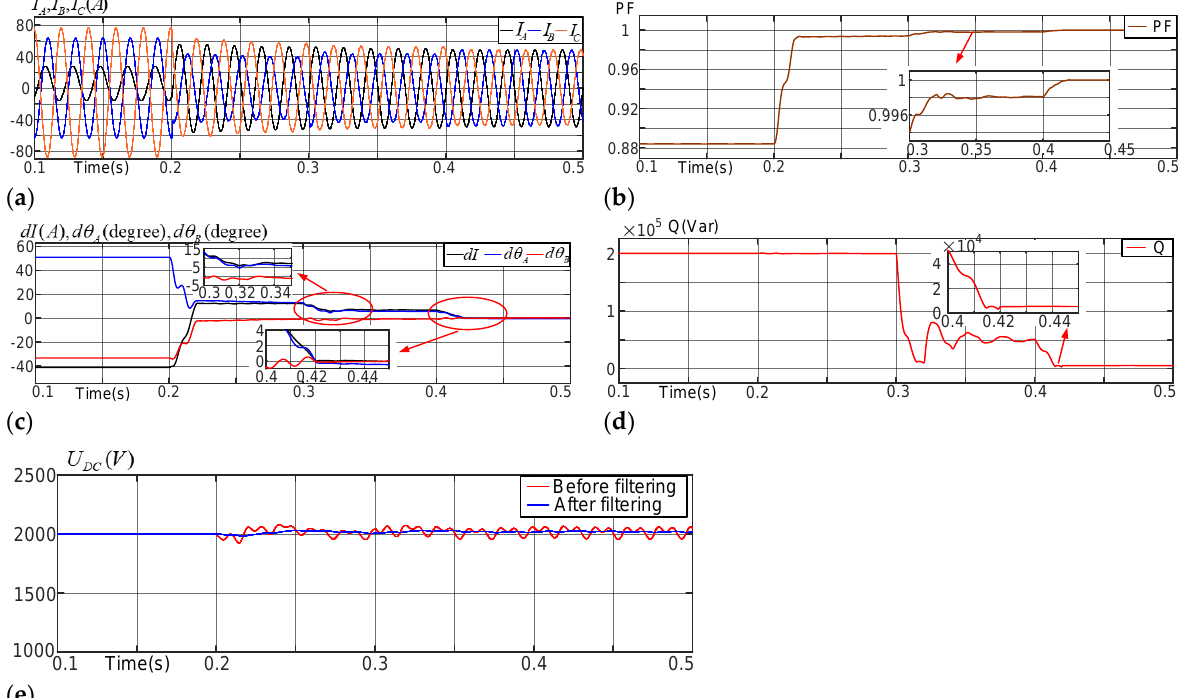
Figure 12. Simulation results of Case 3. ( a ) Primary side currents of V/v transformer I A , I B and I C ; ( b ) Primary side power factor (PF) of the V/v transformer; ( c ) dI , dθ A and dθ B ; ( d ) Total reactive power of the power supply system Q ; ( e ) DC capacitor voltage before and after filtering.